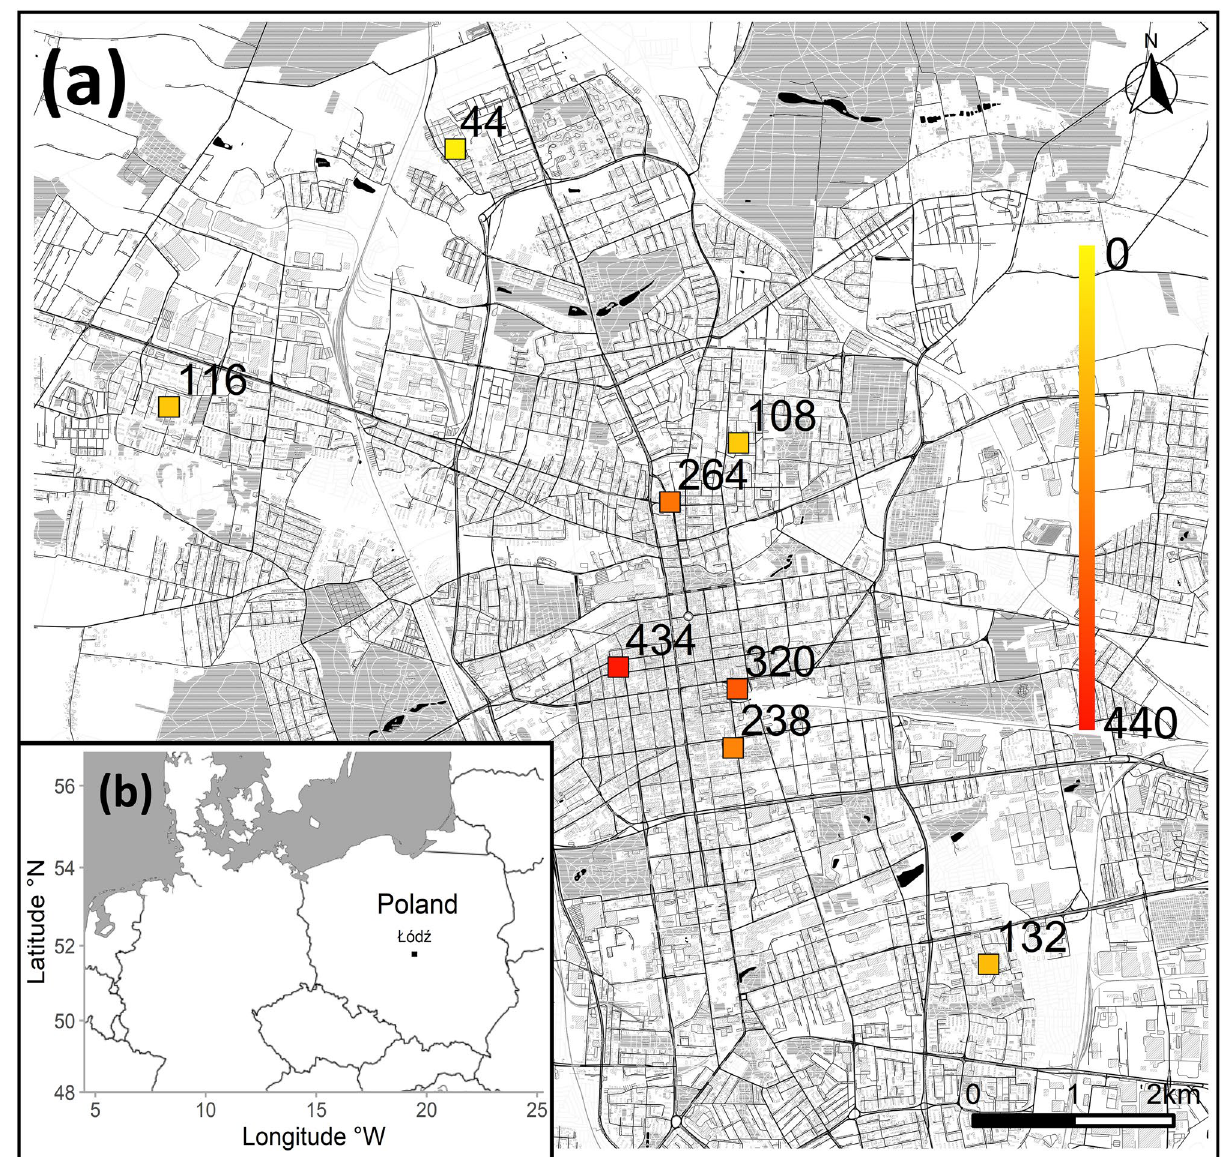
Figure 1. Map of study plots within city of Łódź with numbers of feral pigeons counted at each plot ( a ) and location of Łódź ( b ). The figure was prepared in in R v. 4.0.2 basing on OpenStreetMap tiles (www. opens treet map. org/ copyr ight, licensed under CC